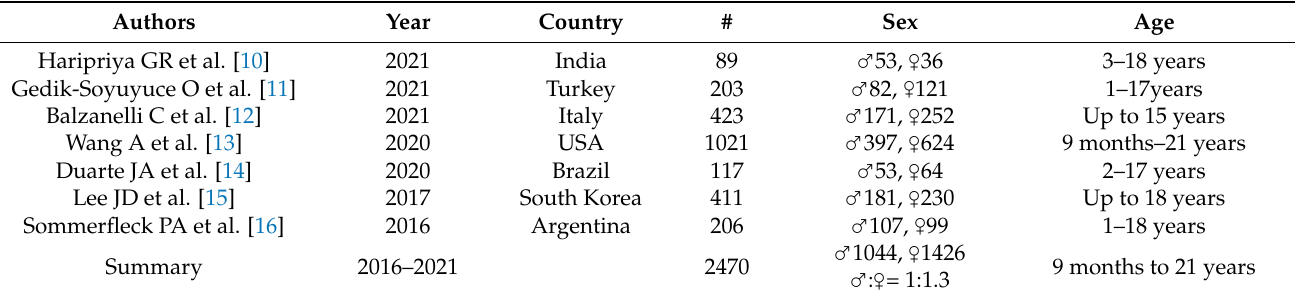
Table 1. Demographics of the different studies included in the review.